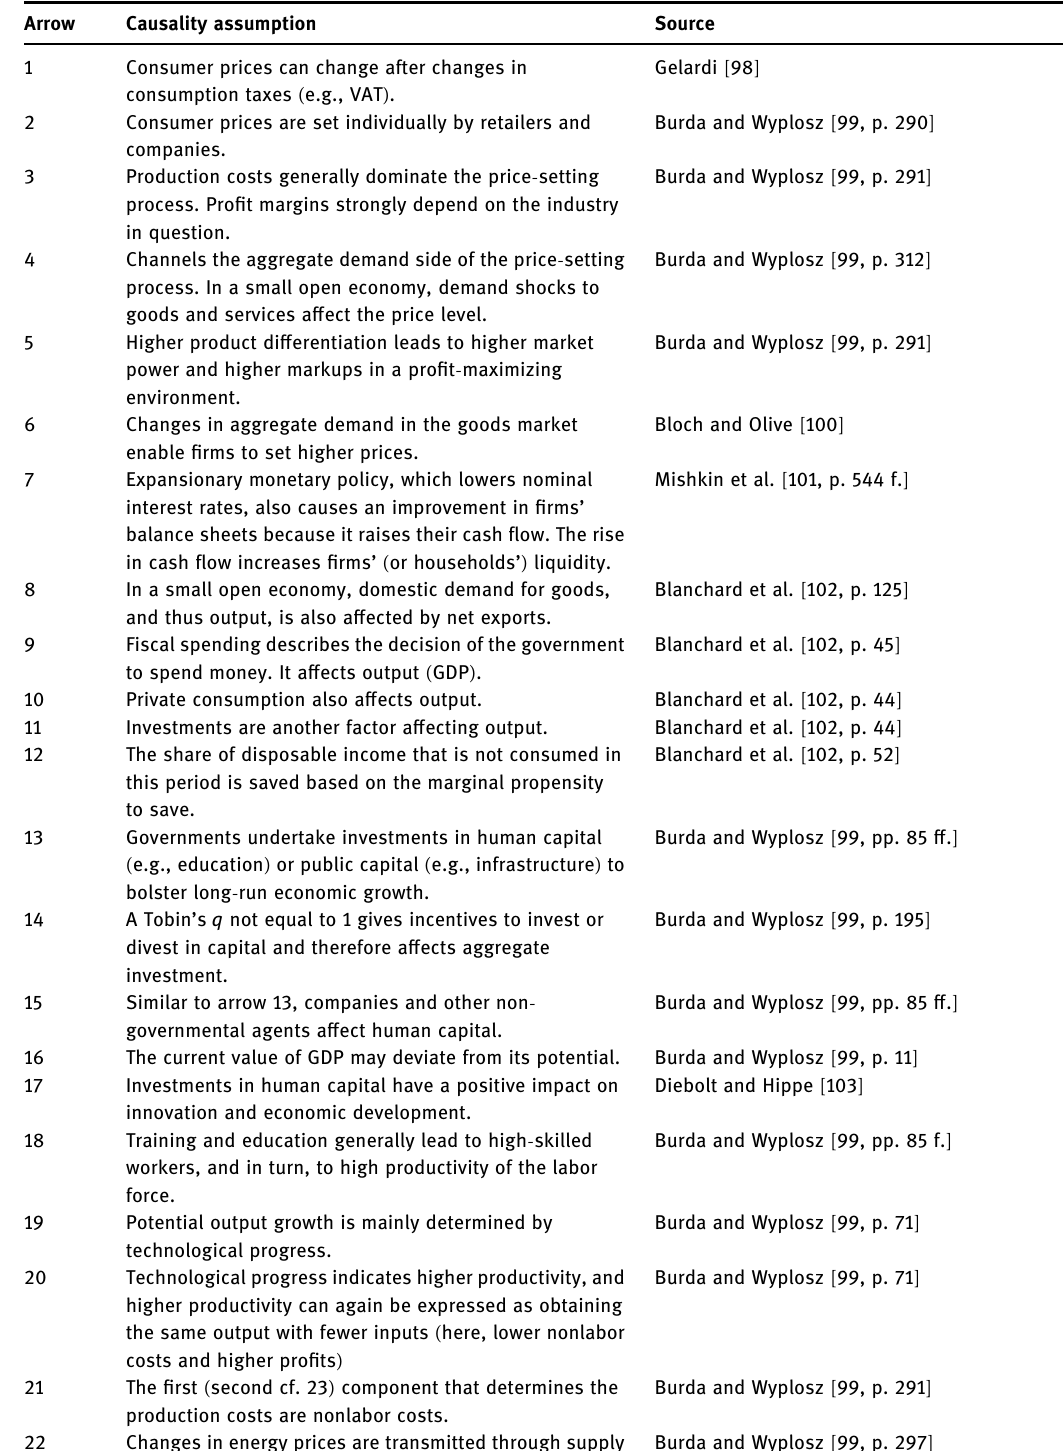
Table 3: Explanation and references for the arrows shown in the causal